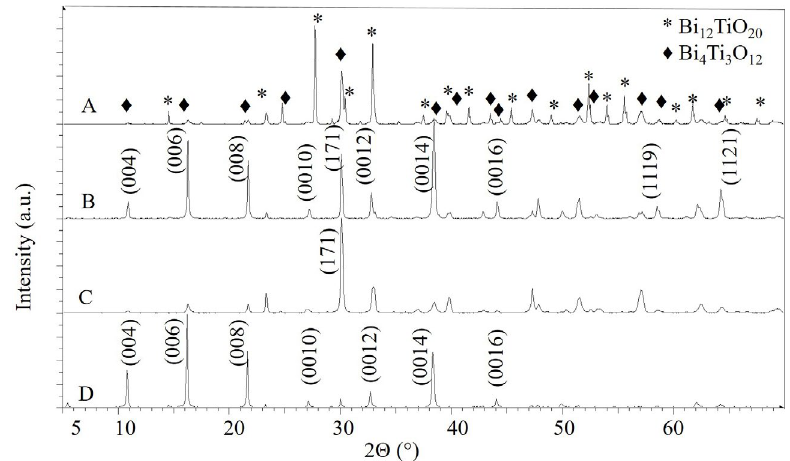
Figure 2: XRD patterns of Bi 4 Ti 3 O 12 plates prepared at 800 ° C for 20 min ( patterns A and C for BIT2) and for 2 h (patterns B and D for BIT8). The A and B patterns represent the XRD patterns of Bi 4 Ti 3 O 12 powders washed only by water in order to determine possible secondary phases. The XRD patterns C (for BIT2) and D (for BIT8) were obtained from Bi 4 Ti 3 O 12 plates that were cast on the Si single crystal. The Bi 4 Ti 3 O 12 plates prepared for examination of their average preferential orientation in these two patterns were washed with 2-M HNO 3 to ensure a single-phase product. In the XRD pattern A, ♦ and * denote the Bi 4 Ti 3 O 12 and Bi 12 TiO 20 phases, respectively. The hkl indexation is given for Bi 4 Ti 3 O 12